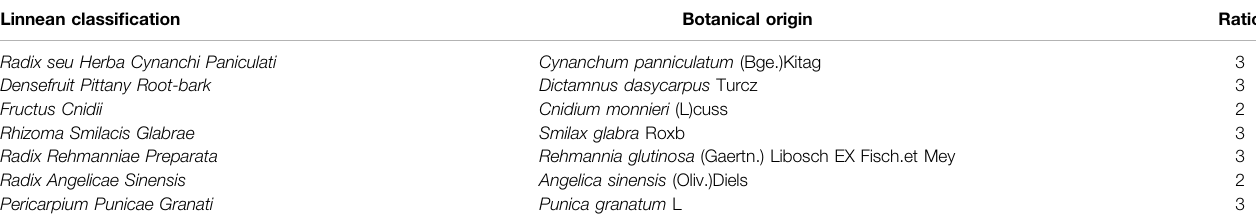
TABLE 1 | Constituents of